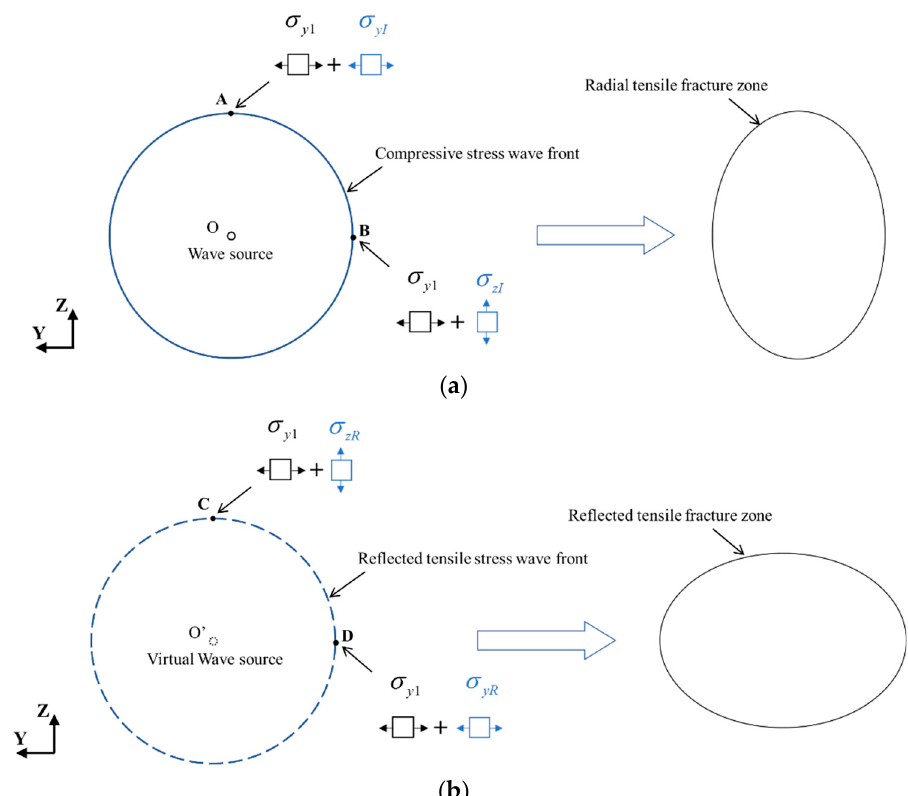
Figure 7. Schematics of superposition of original stress field (P1) and stress wave and its influence on the crater shape: ( a ) radial tensile fracture induced by incident compressive stress wave; ( b ) reflected tensile fracture induced by reflected tensile stress wave.